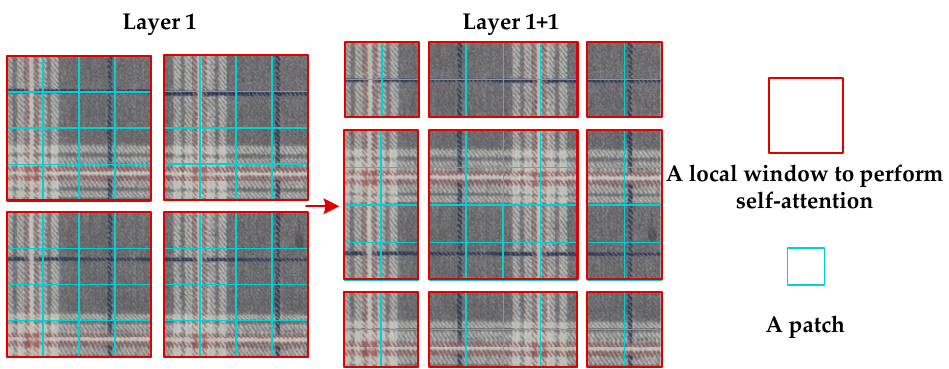
Figure 4. SW-MSA window moves.